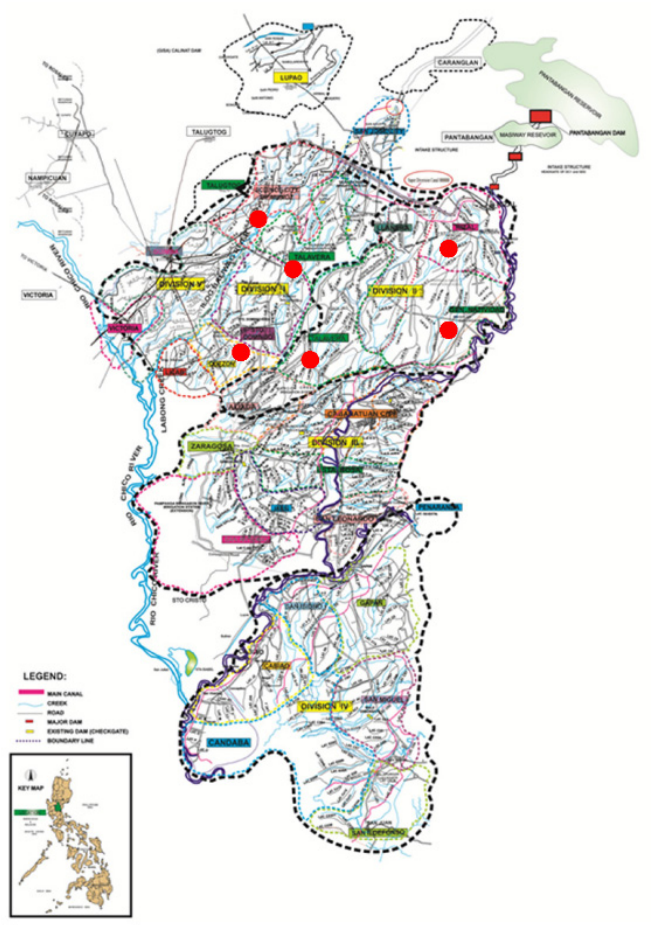
Figure 1. Location map of the area served by the Upper Pampanga River Integrated Irrigation System in Central Luzon. Red circles show the location of the farm-level survey.